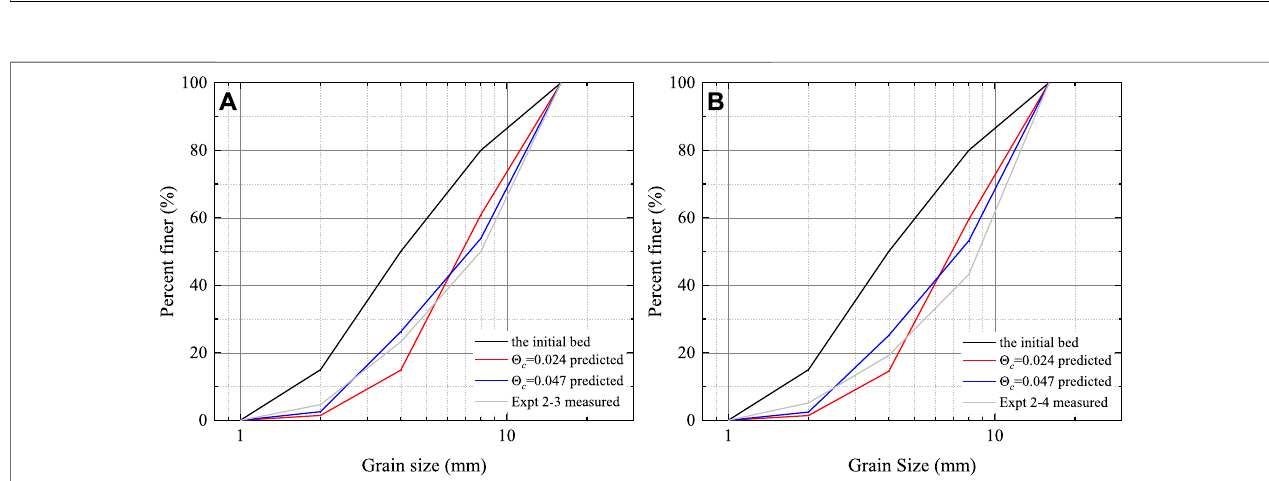
FIGURE 5 | The calculation results of the bed surface size distribution of the new static armor layer formed after instability of the previous armor layer with different critical particle sizes in Experiment two.